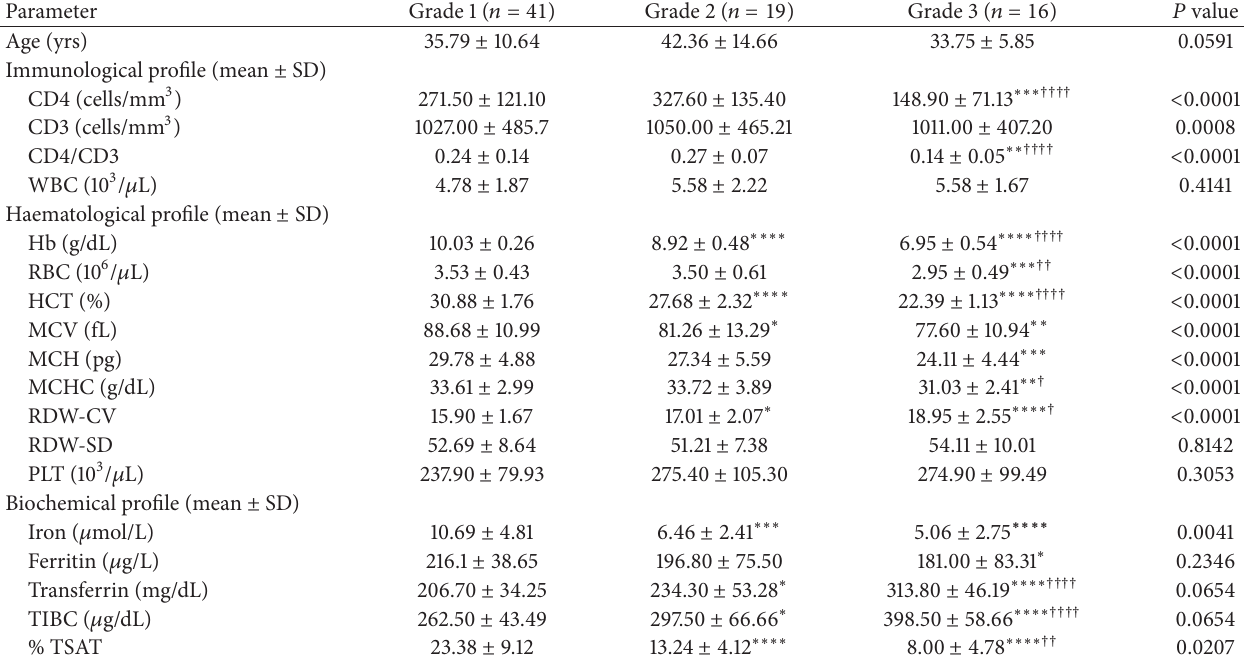
Table 4: Immunological, haematological, and biochemical profiles of the study population stratified by grade of anaemia.